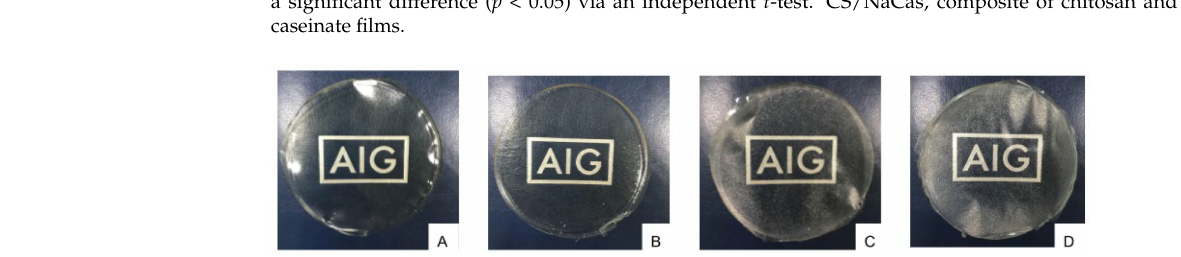
Figure 1. Visual authentication of the transparency for pure chitosan ( A ), sodium caseinate ( B ), chitosan/sodium caseinate composite film ( C ), and chitosan/sodium caseinate composite film with the addition of Lb. fermentum (6.65 log 10 CFU/g) ( D